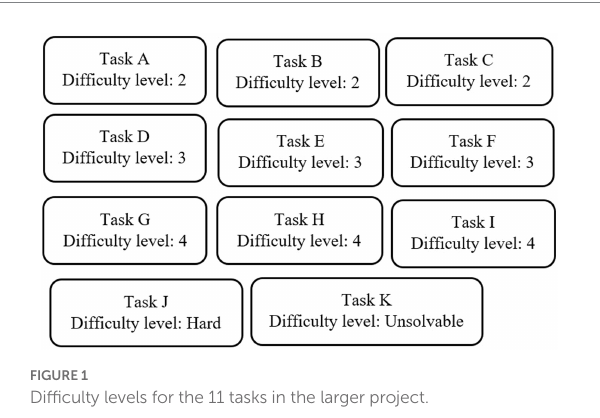
FIGURE 1 Difficulty levels for the 11 tasks in the larger project.